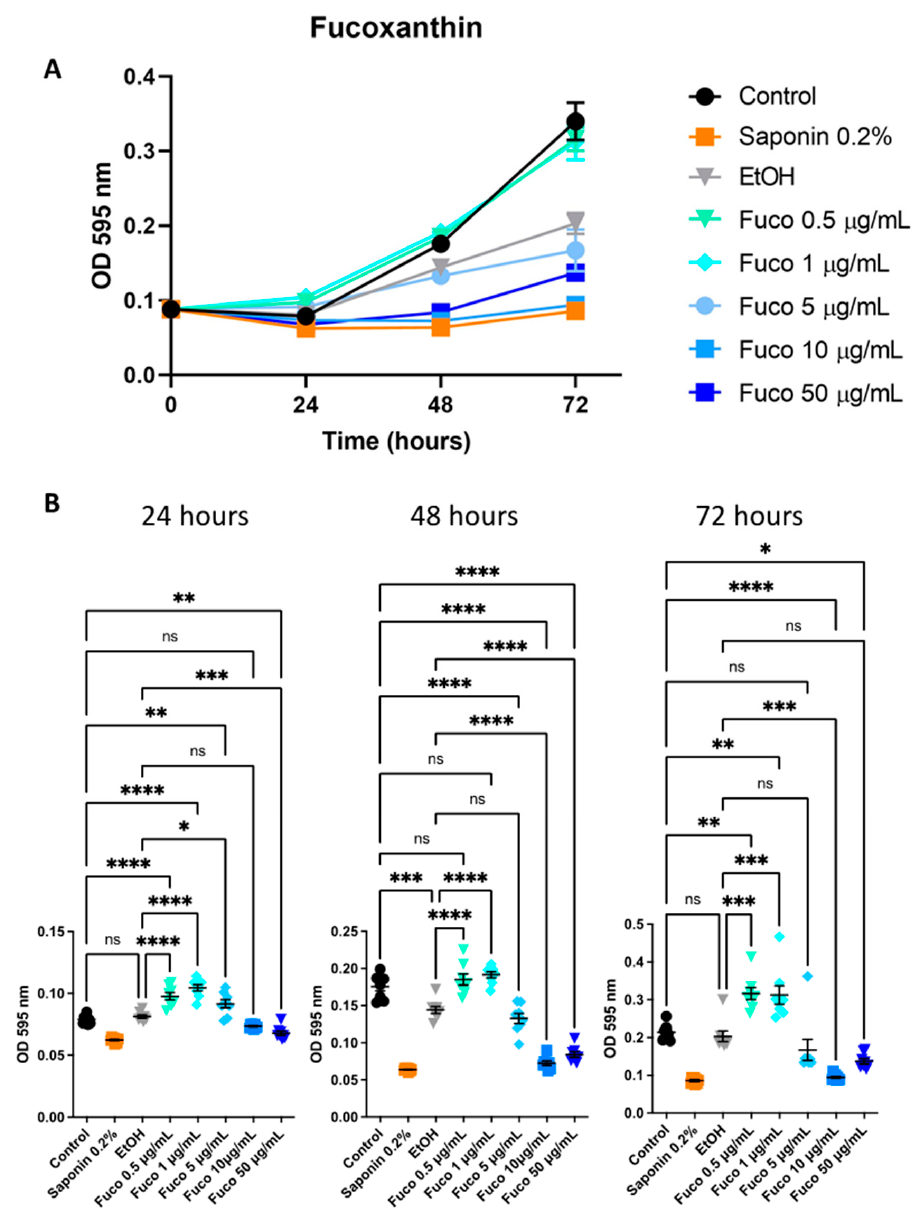
Figure 8. Effects of fucoxanthin on HUVEC proliferation. ( A ) The proliferation rate was measured by crystal violet assay (OD 595 nm) on HUVECs treated with Fuco at 0.5, 1, 5, 10, and 50 µg/mL and corresponding EtOH concentrations, for 24, 48, 72 h. ( B ) Results are represented as mean ± SEM, one-way ANOVA, ns = not significant, * p < 0.05, ** p < 0.01, *** p < 0.001, **** p < 0.0001, ( n = 8).